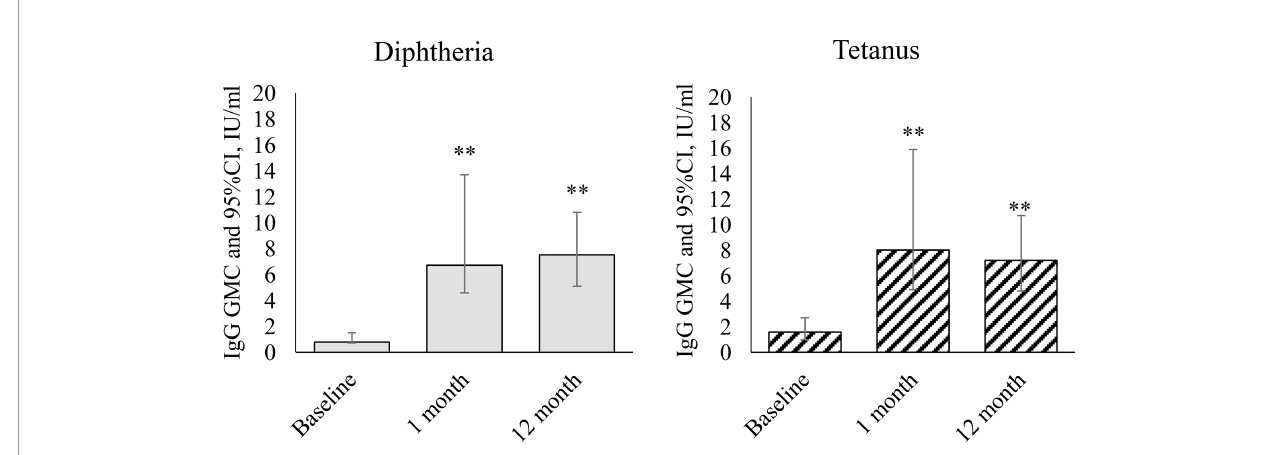
FIGURE 1 | Dynamics of IgG antibodies against diphtheria and tetanus during revaccination with DT toxoid (n = 25). Geometric mean concentrations and their 95% con fi dence interval (GMC [95% CI]). ** – differences from the pre-revaccination value at a level of p < 0.001 (we used the post-hoc Demsar test with a statistically signi fi cant Friedman omnibus